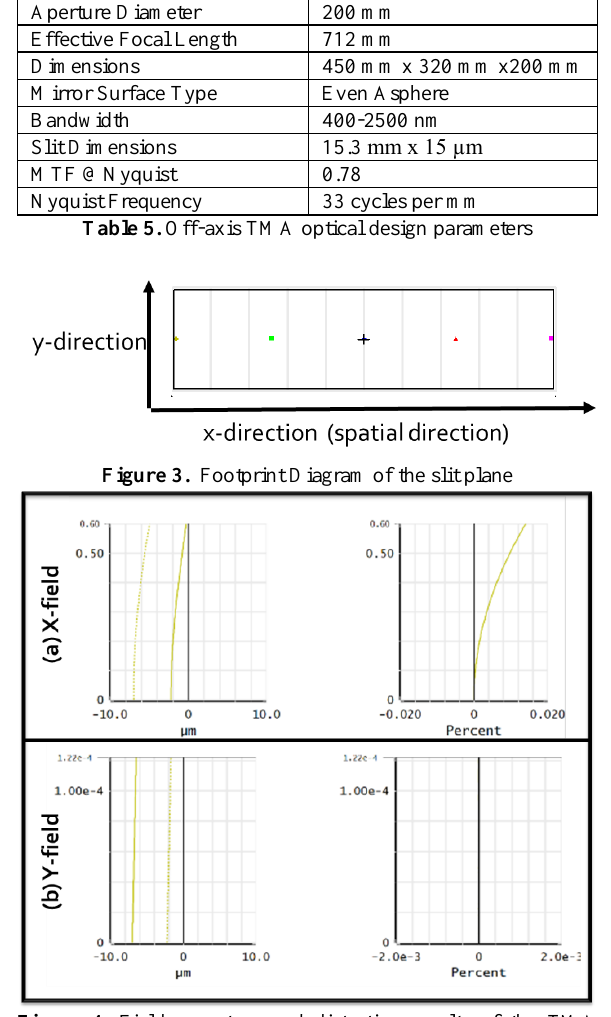
Figure 4. Field curvature and distortion results of the TMA design (a) X-field and (b) Y- field Field curvature and distortion percentages of the TMA design for X-field and Y-field are shown in Figure 4. Field curvature values of X- and Y-field are less than 15 μm and distortion percentages are less than 0.02%. MTF of the final optimized TMA telescope is shown in Figure 5. Nyquist frequency is calculated from the eq. (8). Resulting MTF value of the designed TMA telescope at Nyquist is 0.79. Resulting Spot diagram of the TMA telescope is shown in Figure